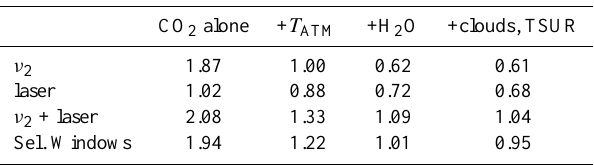
Table 2. Degrees of freedom for CO 2 for one ocean target in differ- ent